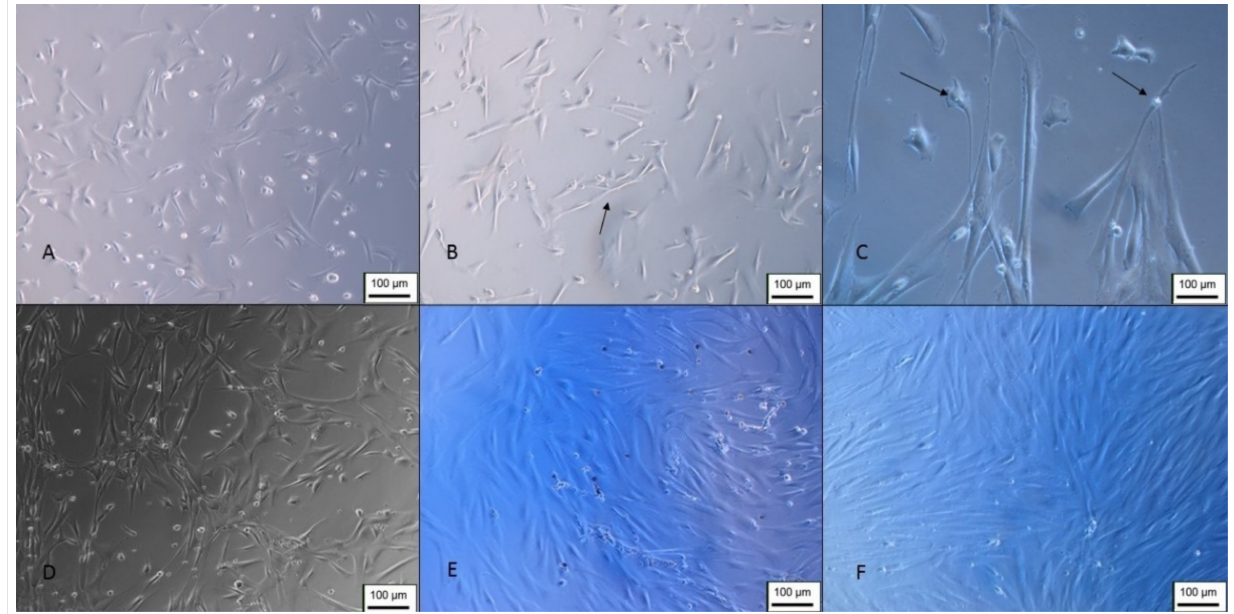
Figure 18. Dopaminergic differentiation of Neural precursors. ( A ) Cells 4 days after induction (100 × ); ( B ) 8 days after induction (100 × ); ( C ) cells 10 days after induction (200 × ); ( D ) cells 15 days after induction (100 × ); ( E ) 20 days of differentiation (100 × ); ( F ) undifferentiated control—100 × (inverted optical microscopy). Scale bar, 100 µ